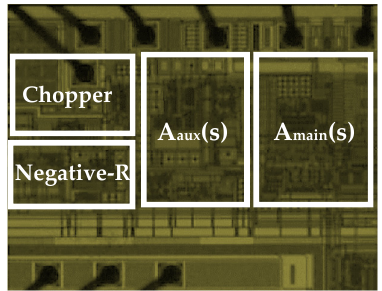
Figure 6. Chip microphotograph of the proposed chopper negative-R stabilization preamplifier in 65 nm CMOS process with an area of 192 µm 2 .